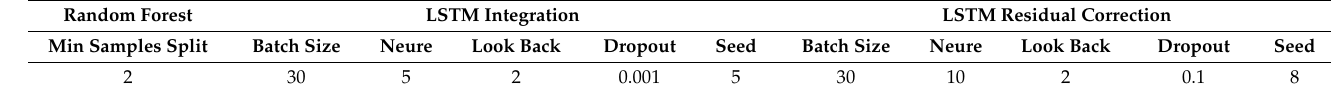
Table 3. Parameters used in case 1.